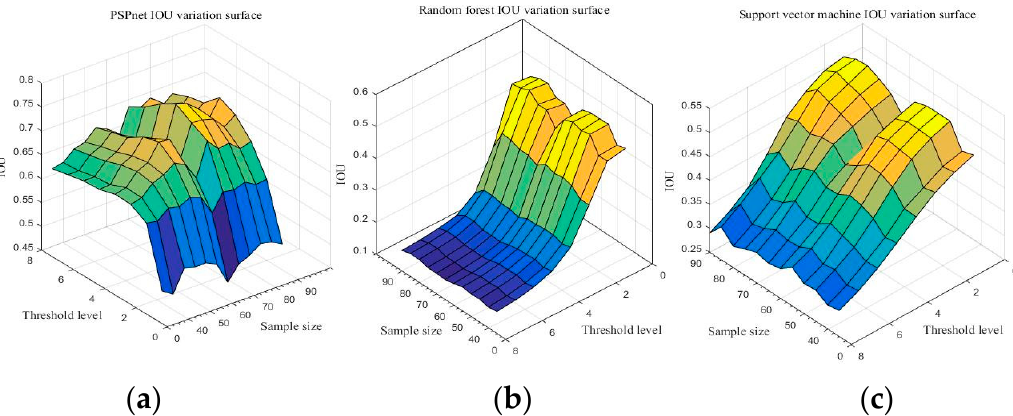
Figure 10. Accuracy of the three segmentation methods under the different sampling scales and threshold levels: ( a ) PSPnet, ( b ) RF, and ( c ) SVM.